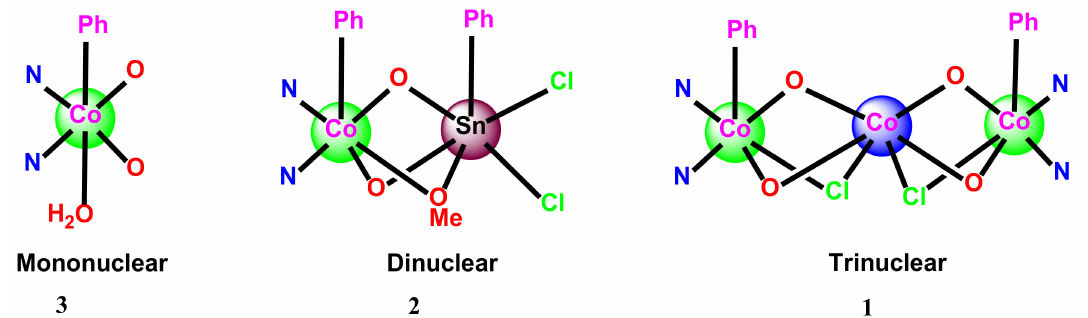
Figure 2. Differences in nuclearity of the organometallic systems 3 , 2 , and 1